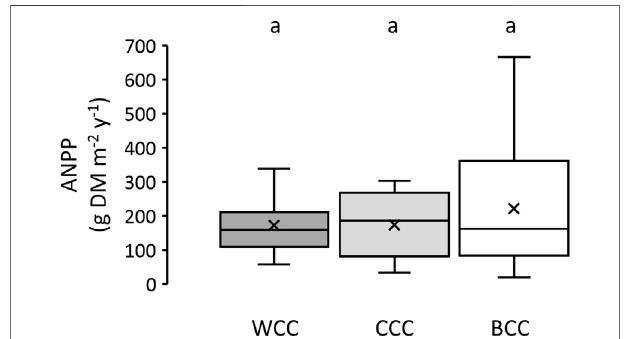
FIGURE 4 | Box and whiskers plot of ANPP for each of the cover crop layout.Horizontalblackline,x-shaped cross,boxborders andwhiskersstand for the median, the mean, quartiles and outliers. Different letters over the box- plot indicate signi fi cant differences ( p < 0.05). WCC, CCC and BCC stand for olives groves where TSCC occupied the whole area, was absent under tree canopy or only occupied a strip of the inter-row area, respectively.